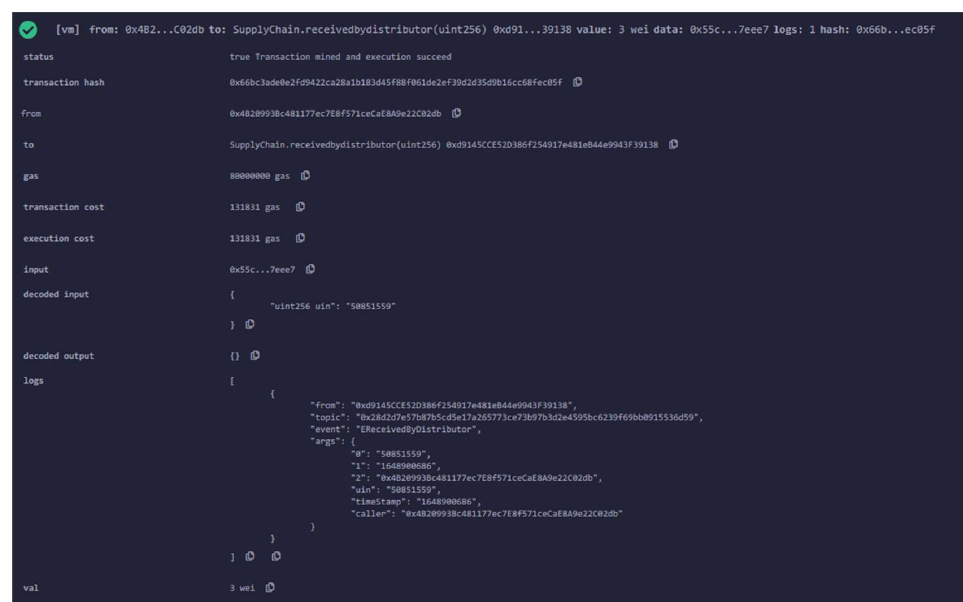
Fig. 12 . Successful verification of